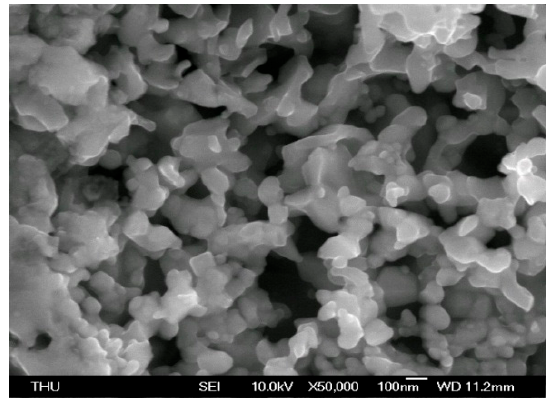
Figure 5. SEM plane-view of the nano-porous poly-Si film by Ag-NPS etched of 1500 s. The irregular nano-porous texture surface and deep pores are clearly observed.